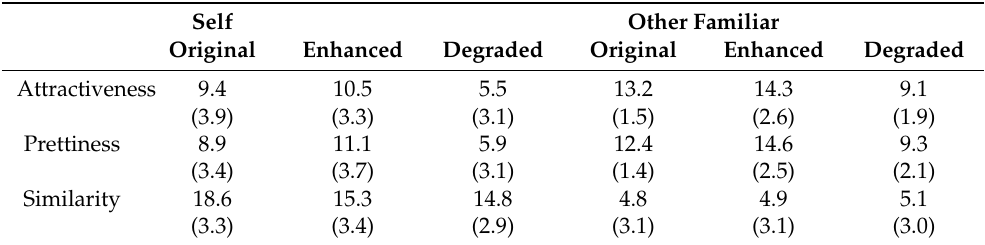
Table 2. Subjective ratings given to faces in each condition. In the parenthesis are the standard